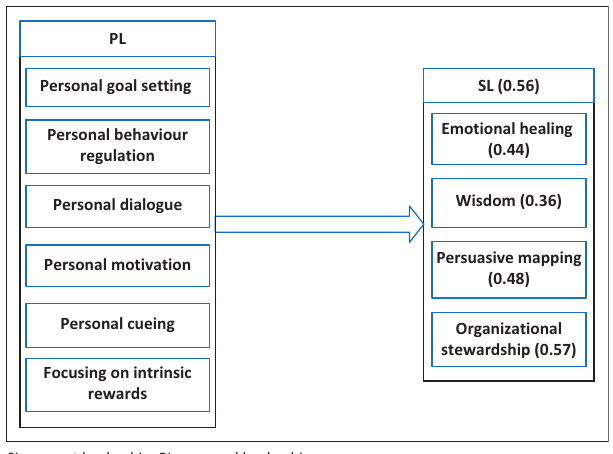
FIGURE 2: An empirical model of personal leadership as an antecedent of servant leadership and its associated